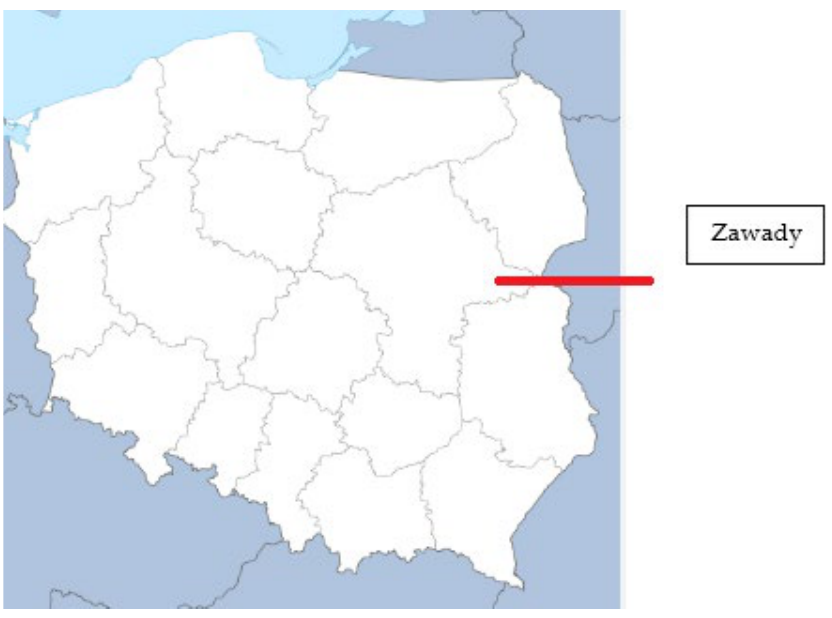
Figure 1. Location of the experiment. Table 2. Description of the preparations used in the experiment and their application doses (dm 3 · ha − 1